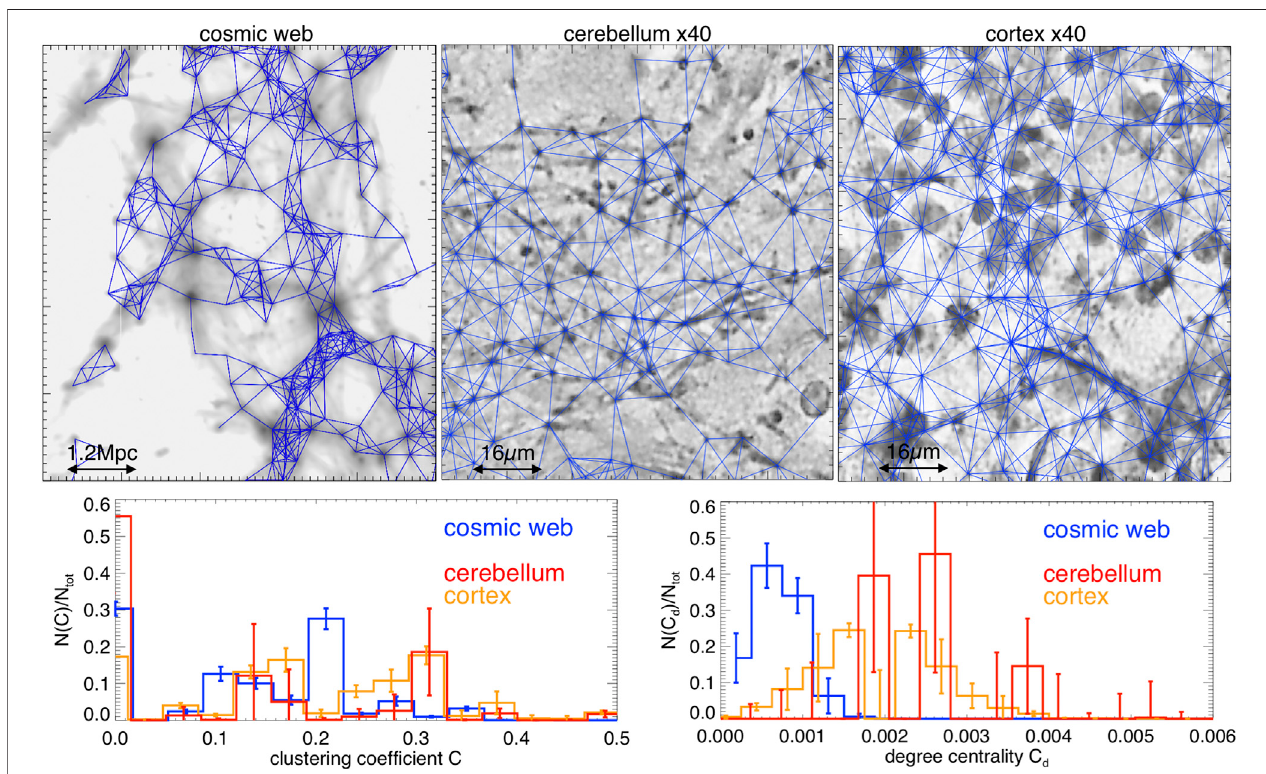
FIGURE 3 | Top panels: zoomed details of the reconstructed connections between nodes for three example of networks in our sample (blue lines, superimposed to the density contrast maps). Bottom panels: distributions of clustering coef fi cient and of degree centrality for all slices (the error bars give the scatter within each investigated sample of slices). The reconstructed connections do not take into account the long-range neural connections, and the clusters shown are purely spatial.